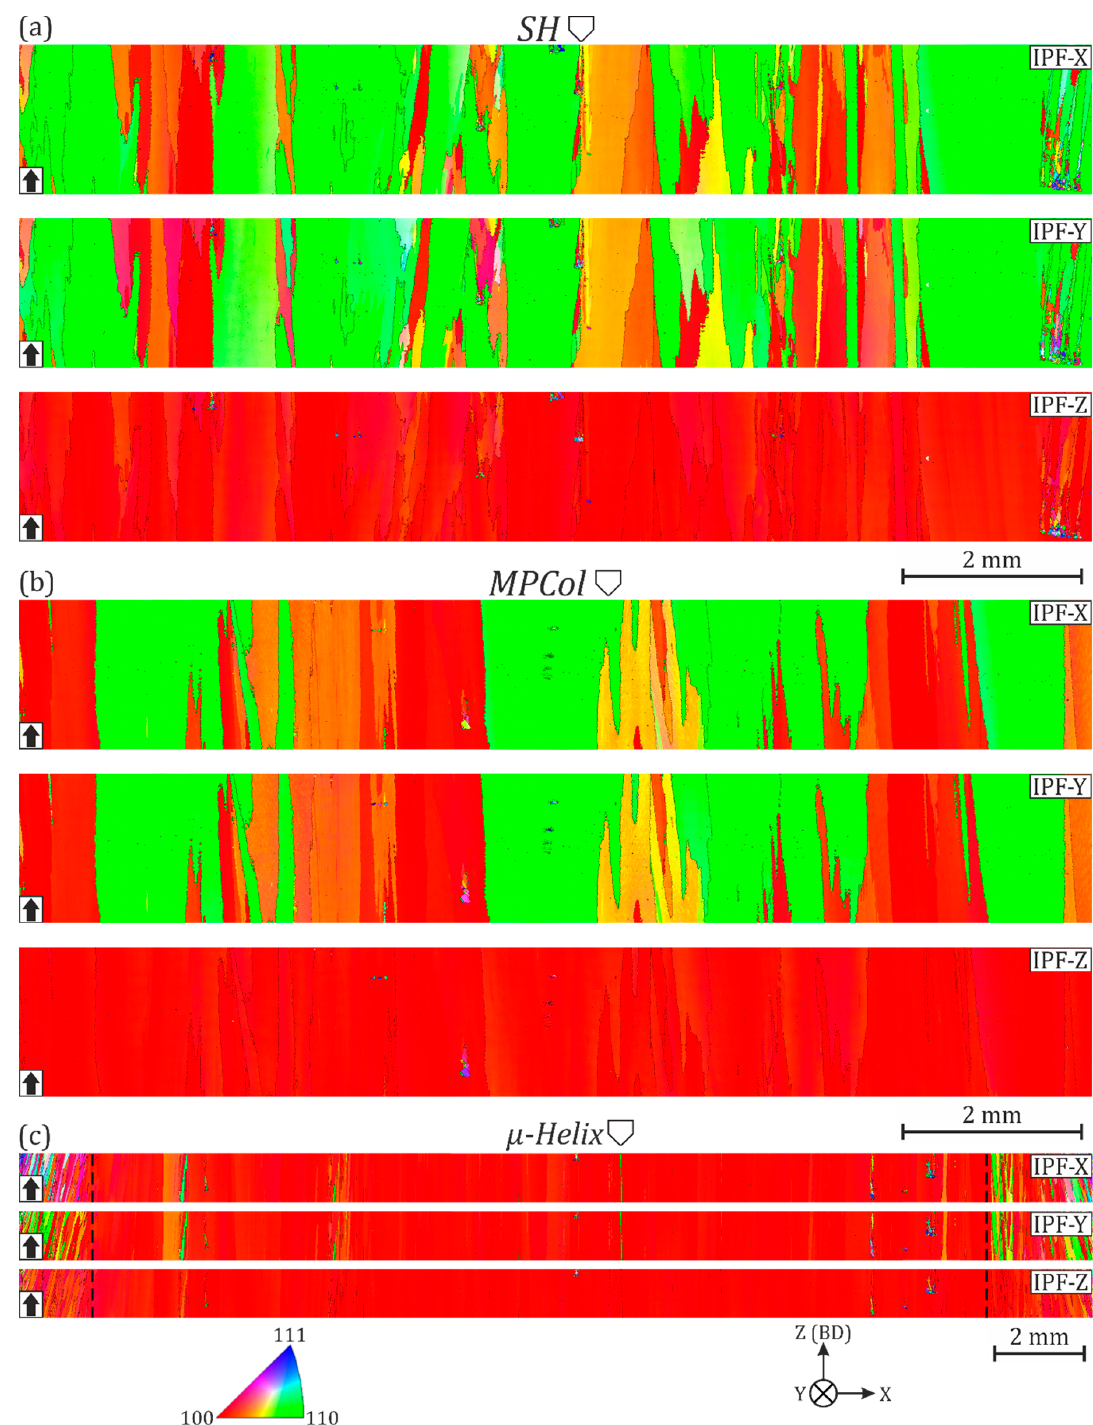
Figure 6. Large area EBSD-IPF maps of trapezoidal prisms manufactured with di ff erent SEBM Figure 6: Large area EBSD-IPF maps of trapezoidal prisms manufactured with different SEBM processing parameters: ( a ) SH, ( b ) MPCol, ( c ) µ -Helix. The build direction is indicated by the black processing parameters: ( a ) SH, ( b ) MPCol, ( c ) µ-Helix . The build direction is indicated by the black arrows. Grain boundaries with a misorientation angle of > 10 ◦ are highlighted with black lines. arrows. Grain boundaries with a misorientation angle of > 10° are highlighted with black lines. The The dashed lines indicate the region of interest for the pole figure of the µ -Helix dashed lines indicate the region of interest for the pole figure of the µ-Helix sample.